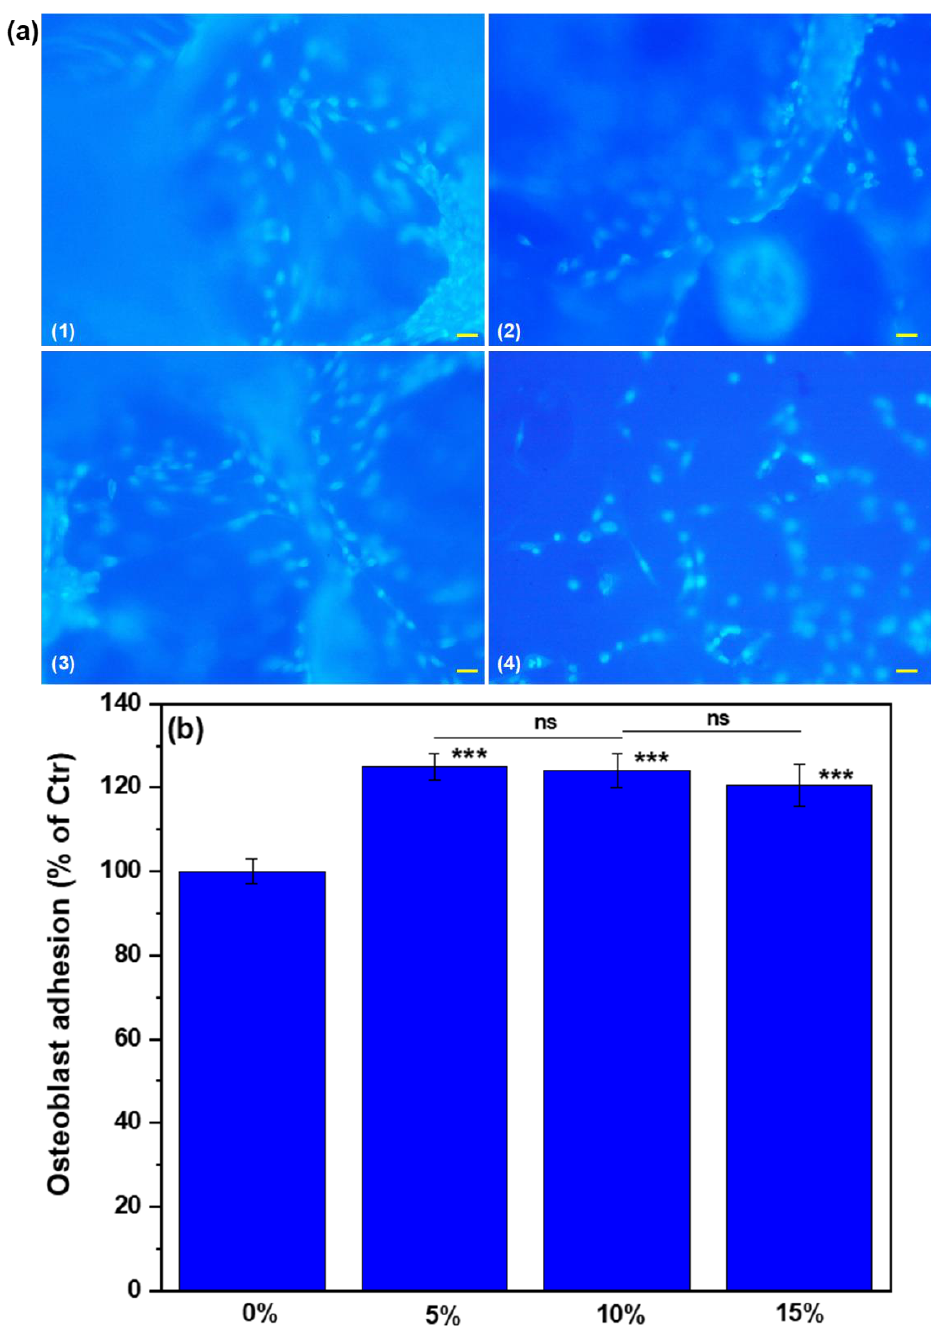
Figure 10. Osteoblast adhesion into PLA/CS-g-PLA porous scaffolds: ( a ) Hoechst staining; ( b ) MTS assays. (Scale bar on the pictures = 50 µm). (*** p ˂ 0.001; ns = not significant). Osteoblast Cells Proliferation